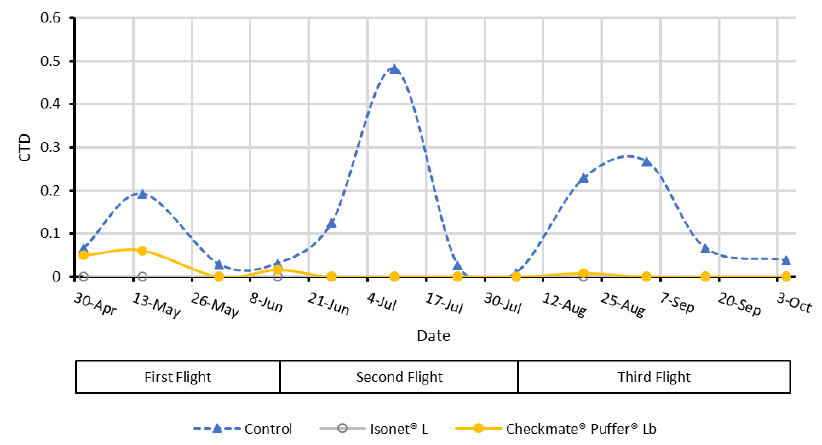
Figure 7. Mean of male captures per trap per day (CTD) throughout the season at Location 1 and 2 in the plots with different treatments.